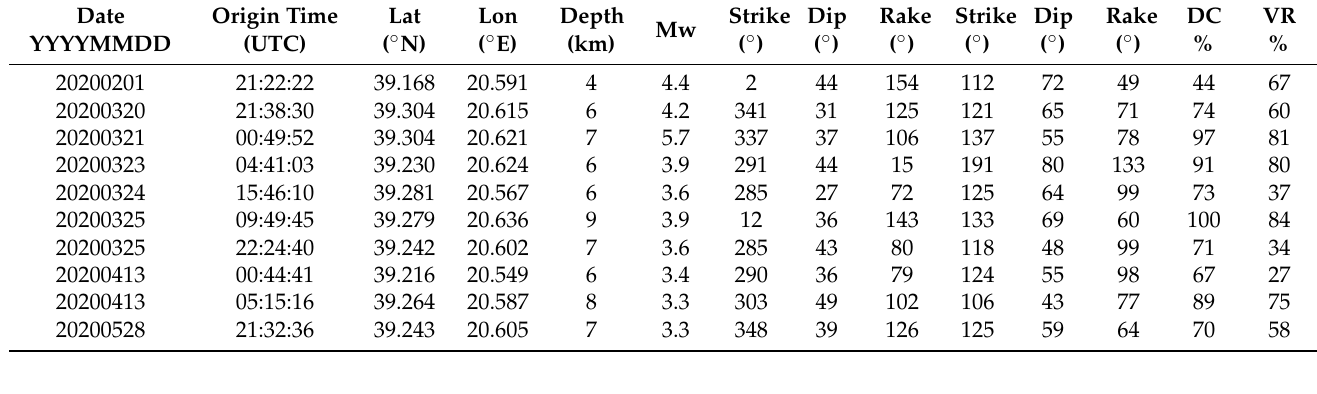
Table 3. Moment Tensor Solutions of foreshocks and major aftershocks (this work).